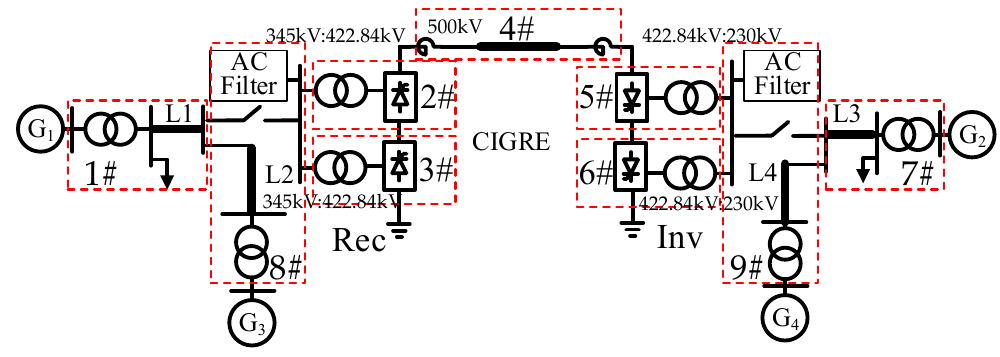
Figure 11. The four-machine AC/DC hybrid system.